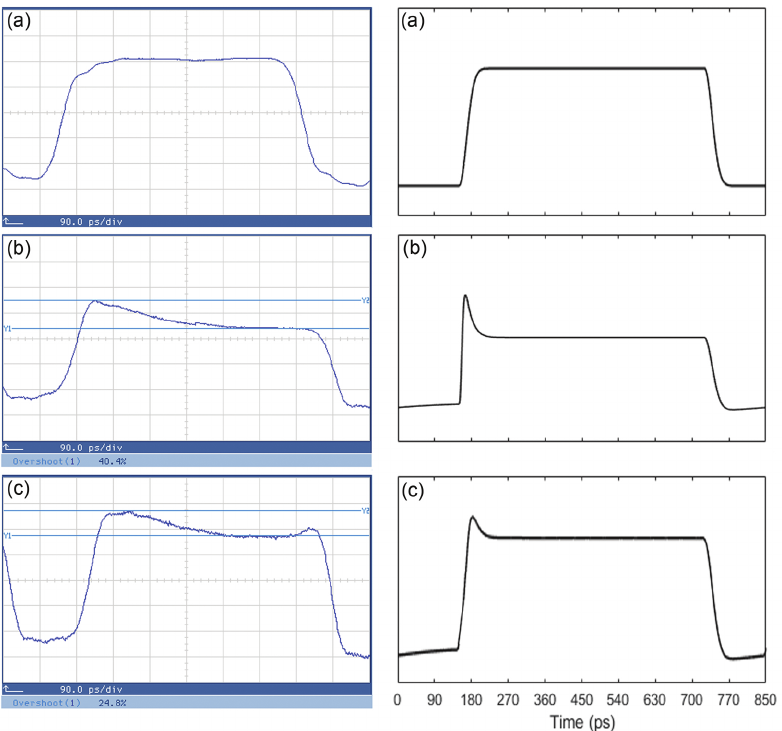
Figure 6. Consecutive “1”s profile at the RSOA input ( a ), RSOA output ( b ) and BFL output ( c ). Left column: experimental results. Right column: simulation